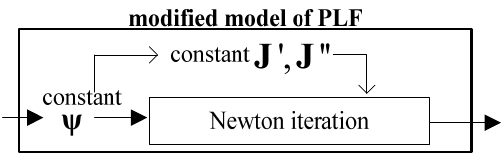
Figure 5. Modified calculation model of SG ‐ PLF.